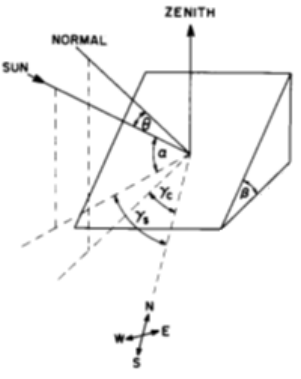
Figure 14. Angles involved in solar radiation calculations.